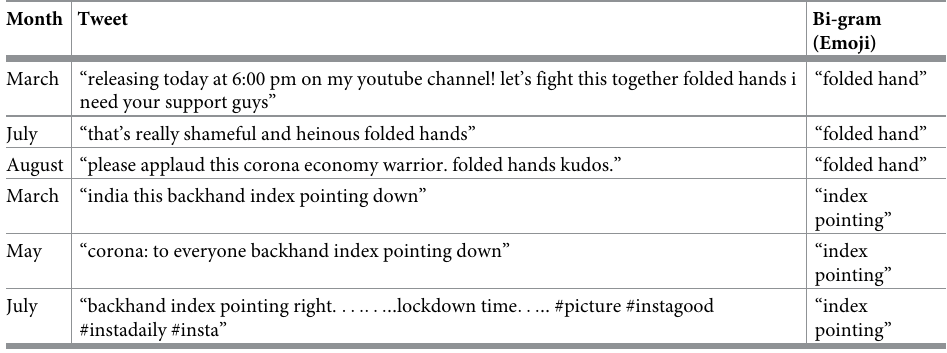
Table 3. Selected examples of processed tweets that are captured in most prominent